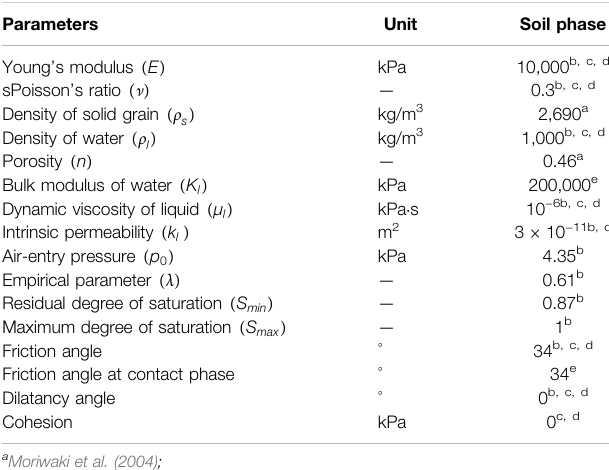
TABLE 1 | Material parameters for the rainfall-induced slope